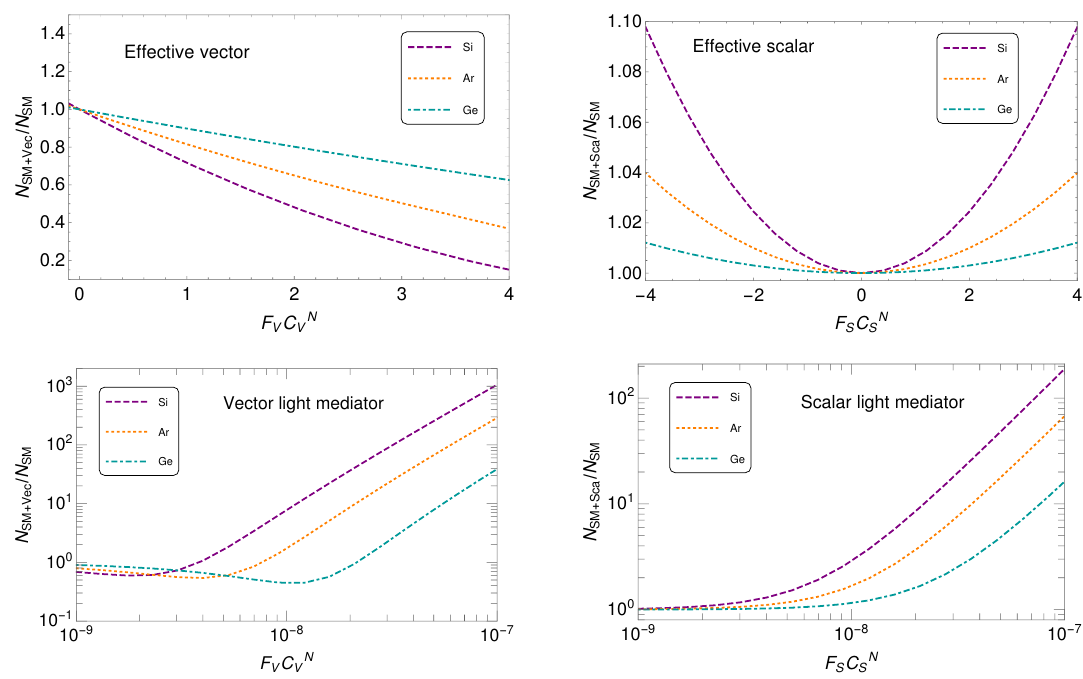
Figure 6 . Top-left graph : number of events normalized to the SM expectation in silicon, argon and germanium detectors assuming parameter space degeneracy in a xenon detector C N = 0. The X j Xe result was obtained assuming E th = 0 : 1 keV and an e(cid:11)ective vector interaction. Top-right graph r Same as in the top-left graph but for e(cid:11)ective scalar interactions. Both results demonstrate that the silicon detector performs better for degeneracy removal and allow to distinguish in almost all parameter space vector from scalar signals. Bottom-left graph : same as in the top-left graph but for vector light mediators. As in the e(cid:11)ective case | in general | silicon performs better. However in contrast to the e(cid:11)ective case the signal is more degraded (below the SM) in germanium, so whether silicon or germanium are more suited for breaking xenon degeneracies depends on where the values of the parameters fall in. Bottom-right graph : same as in the top-left graph but for scalar light mediators. For light mediators scenarios the calculation has been done (cid:12)xing m X = 1 MeV, value for which e(cid:11)ects are maximized (within the mass range we are